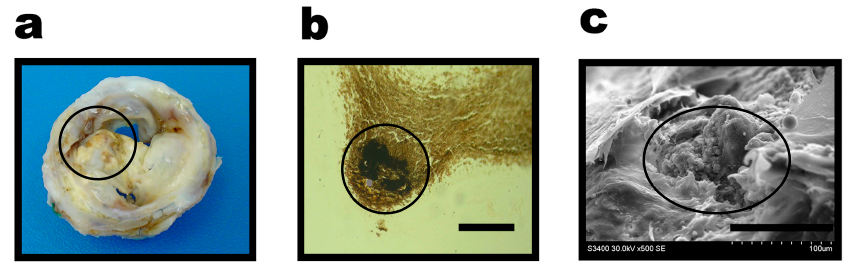
Figure 1. Bioprosthetic valve calcification: ( a ) explanted bioprosthetic heart valve; ( b ) von Kossa staining, scale bar = 50 µ m; ( c ) scanning electron microscopy. Calcified areas are indicated as black circles.